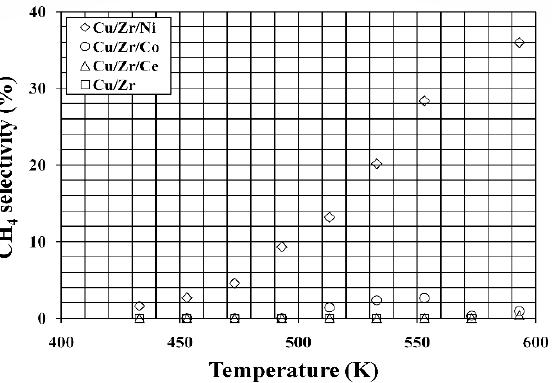
Figure 7. The effect of temperature on CO selectivity in ESR over tested catalysts.